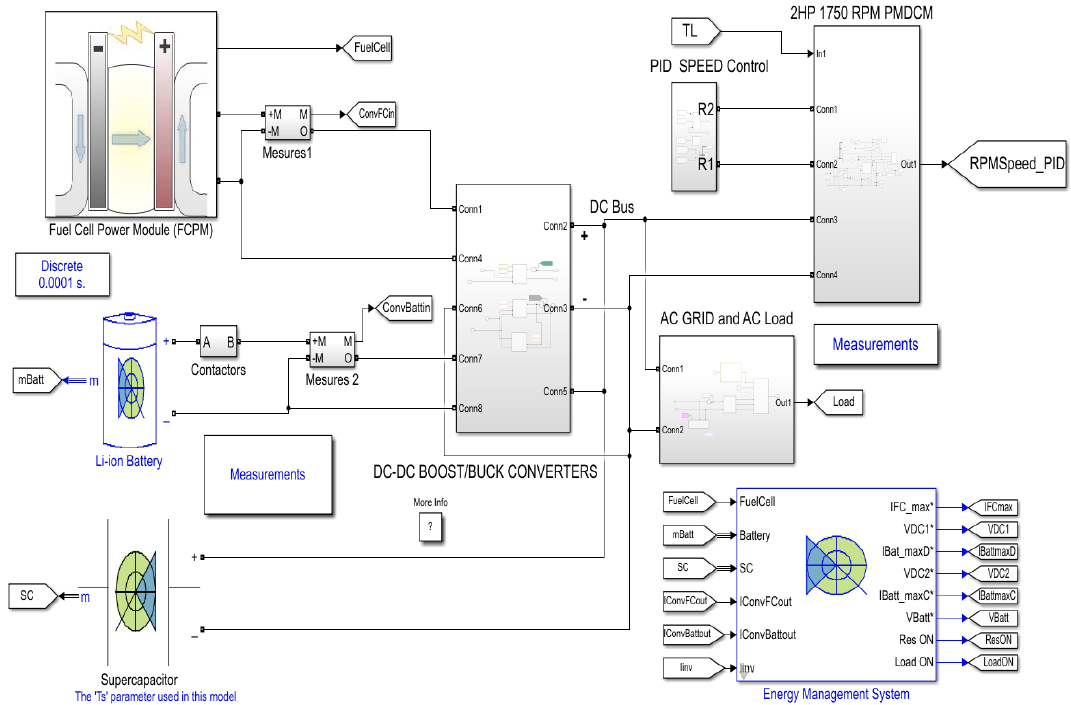
Figure 22. The adapted EMS of HEV SMCAR—Simulink Simscape diagram (adapted from Noya, [5,7]).